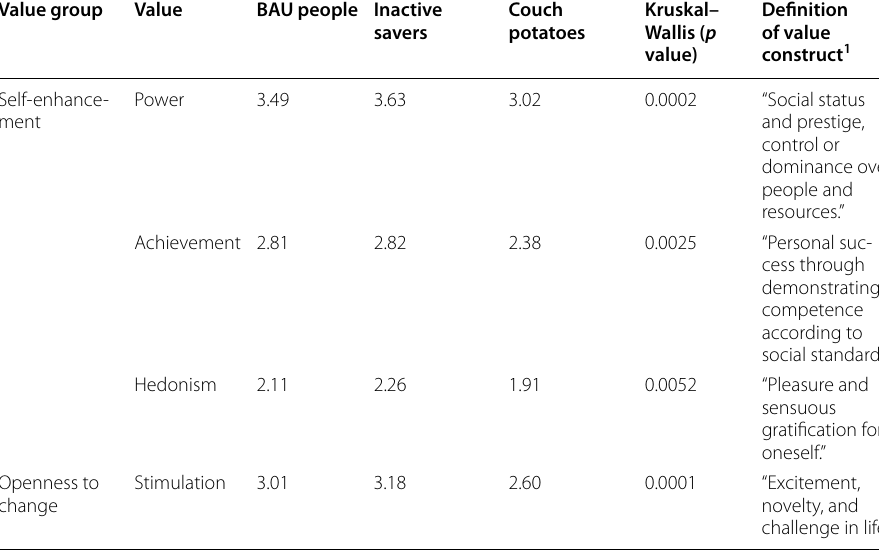
1 Definitions taken from Schwartz et al. (2012), Table 1, p. 521 2 lower values indicate higher